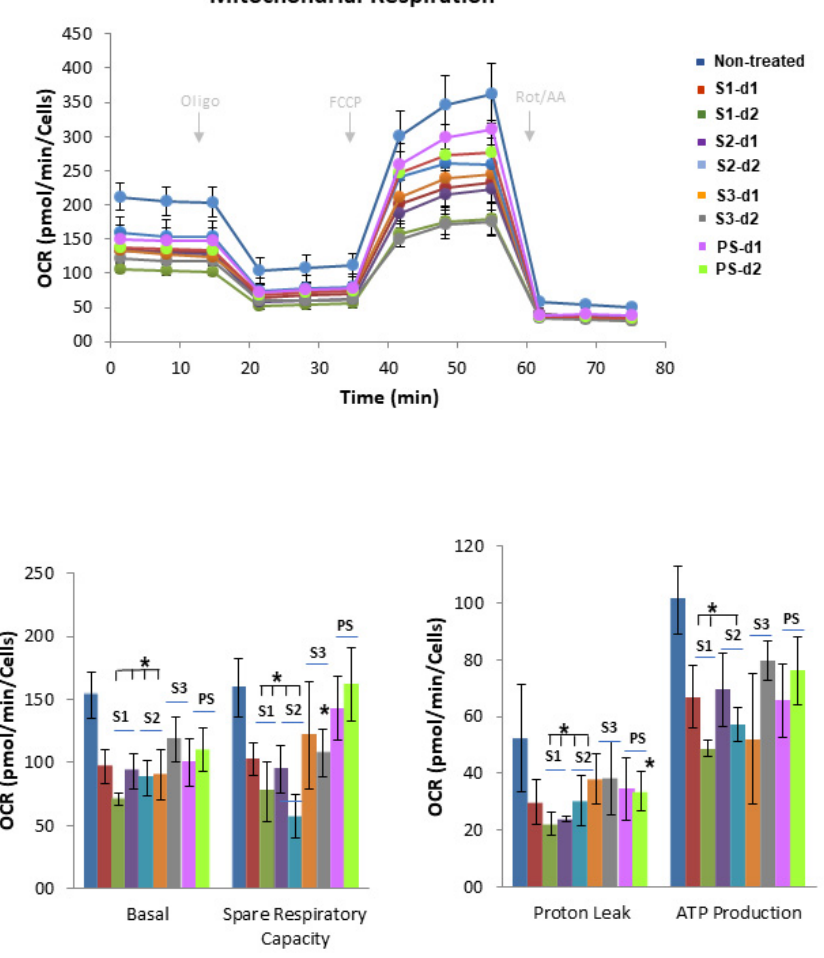
Figure 4. S1 and S2 diminish the mitochondrial oxidative phosphorylation. Mitochondrial respira- tion quanti fi cation by fl ux analysis of the oxygen consumption rate (OCR) of DLD1 cells previously pre-treated with SFE extracts for 48 h. The basal respiration rate, spare respiratory capacity, ATP production, and proton leak of 8000 cells per condition are compared. Data represent mean ± SEM of three independent experiments, each performed with four to six replicates. Asterisks * indicate p value < 0.05.